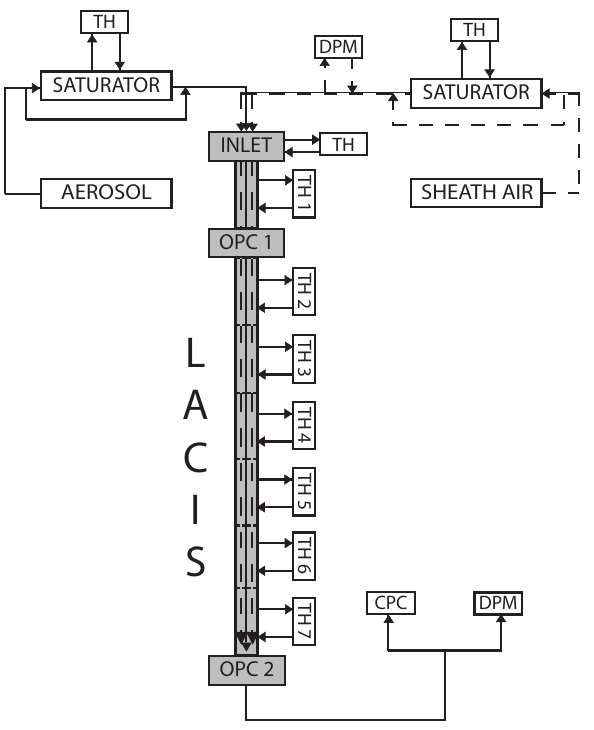
Fig. 1. Schematic of LACIS setup with conditioning part, cloud chamber/laminar flow tube and detection system (OPC 1 and Fig. 11. Schematic of LACIS setup with conditioning part (item 1), OPC 2). The abbreviation TH means thermostat, DPM represents cloud chamber/laminar flow tube (item 2) and detection system chilled mirror dew point hygrometer, CPC depicts the condensa- (OPC 1 and OPC 2). The abbreviation TH means thermostat, DPM tional particle counter and OPC stands for optical particle represents chilled mirror dew point hygrometer, CPC depicts the condensational particle counter and OPC stands for optical particle counter.